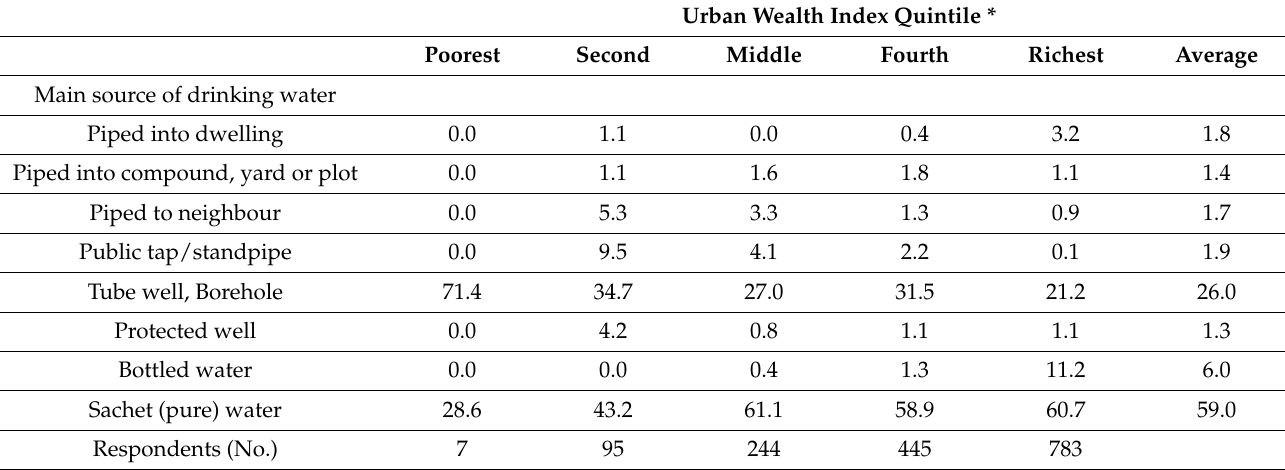
Table 6 examines the relationship between household wealth and reported drinking water source using the ‘urban wealth’ measure contained in the MICS survey. This measure is calculated according to the assets that respondents report are owned by the household. The data is grouped in quintiles at the national level. Table 6. Analysis of principal drinking water sources according to urban wealth quintiles (%, respondents). Urban Wealth Index Quintile * Poorest Second Middle Fourth Richest